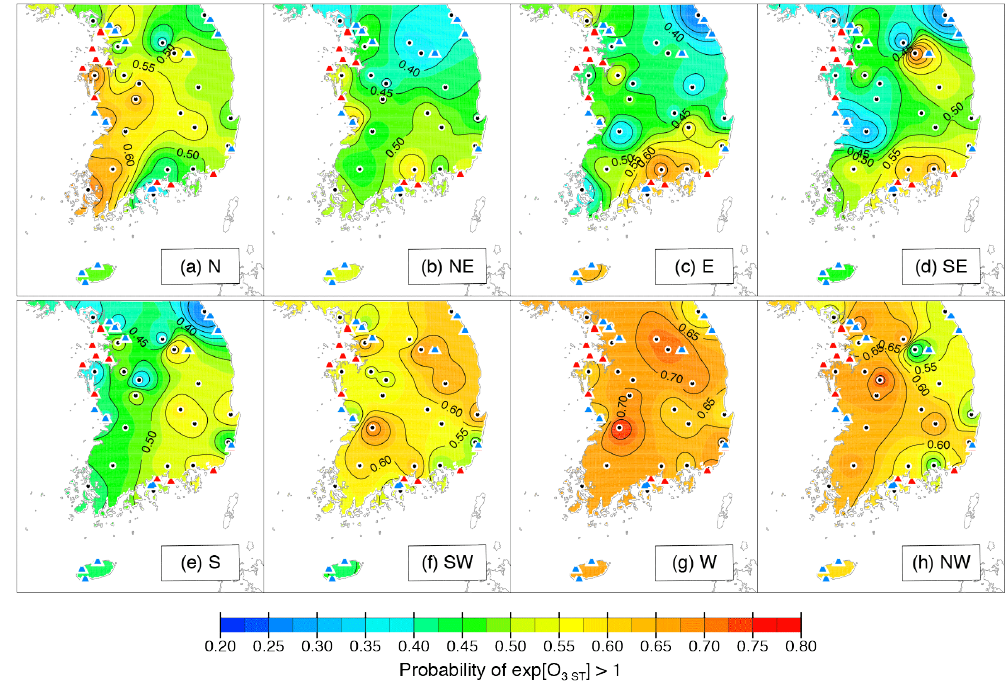
Figure 11. Spatial distributions of probabilities that exponentials of the short-term components will exceed 1 (exp[O 3ST ]>1) for each WD: (a) northerly (N), (b) northeasterly (NE), (c) easterly (E), (d) southeasterly (SE), (e) southerly (S), (f) southwesterly (SW), (g) westerly (W), and (h) northwesterly (NW), respectively. Black dots denote 25 weather stations of KMA and triangles denote 26 major thermoelectric power plants in South Korea (blue triangle <1000MW, red triangles ≥